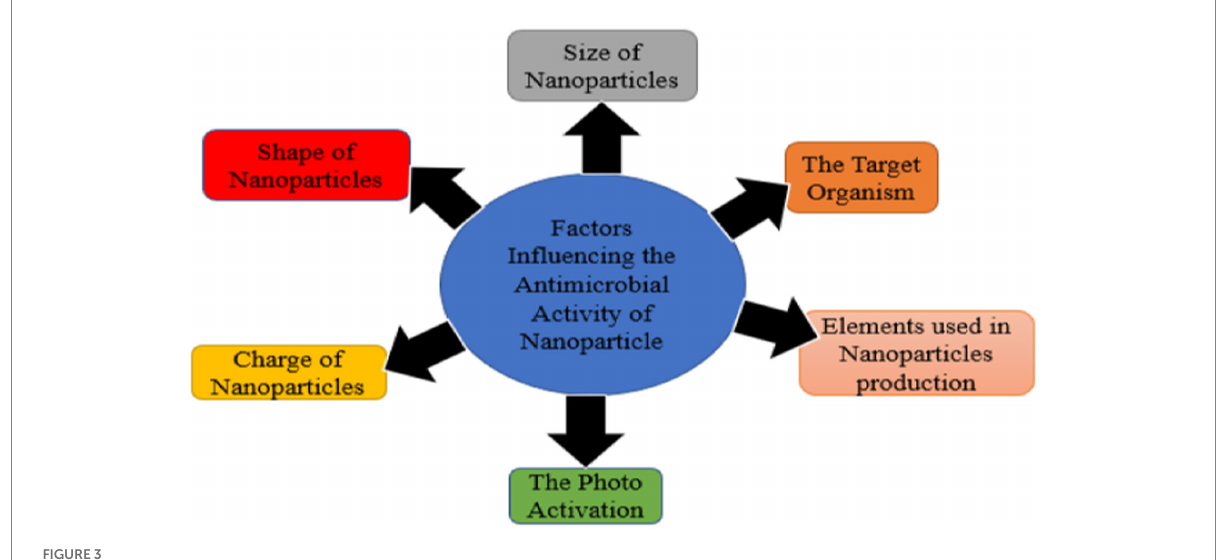
FIGURE 3 Factors influencing antimicrobial activity of